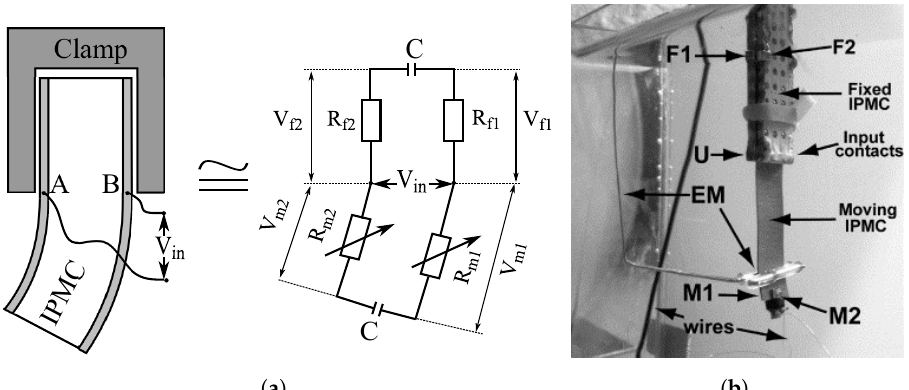
Figure 16. IPMC self-sensing actuation method that immobilizes half of the IPMC to provide reference impedances [9]. Surface resistances of the fixed ( R f 1 and R f 2 ) and mobile half of the IPMC ( R m 1 and R m 2 ) vary differently, and voltage difference between ends of the electrodes ( V m 1 − V f 1 and V m 1 − V f 1 ) correlate with bending. ( a ) Schematic view. ( b ) Experimental set-up, reprinted from [9], Copyright (2007), with permission from Elsevier.